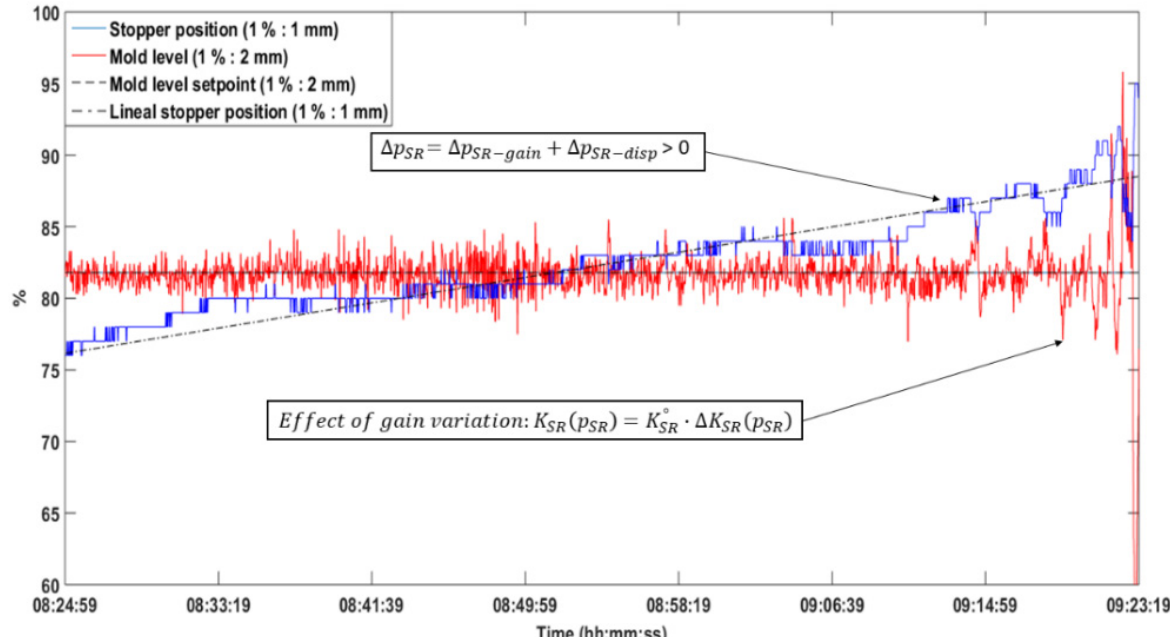
Figure 2. Real data from a cast with stopper rod (SR) clogging in the case study.